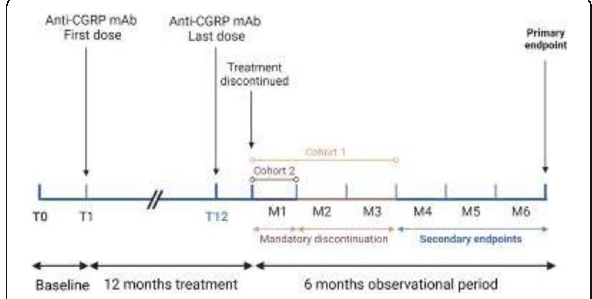
Fig. 1 (abstract P259). See text for description.